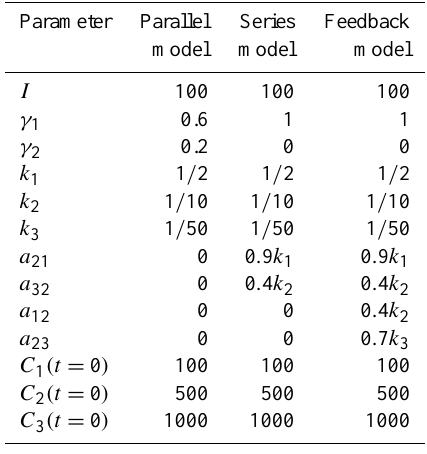
Figure 4. Predictions of respired radiocarbon values from the model of Eq. (21) vs. observations. Model predictions include uncer- tainty range for the mean ± standard deviation, and the minimum– maximum range. Radiocarbon concentration in the atmosphere is depicted in